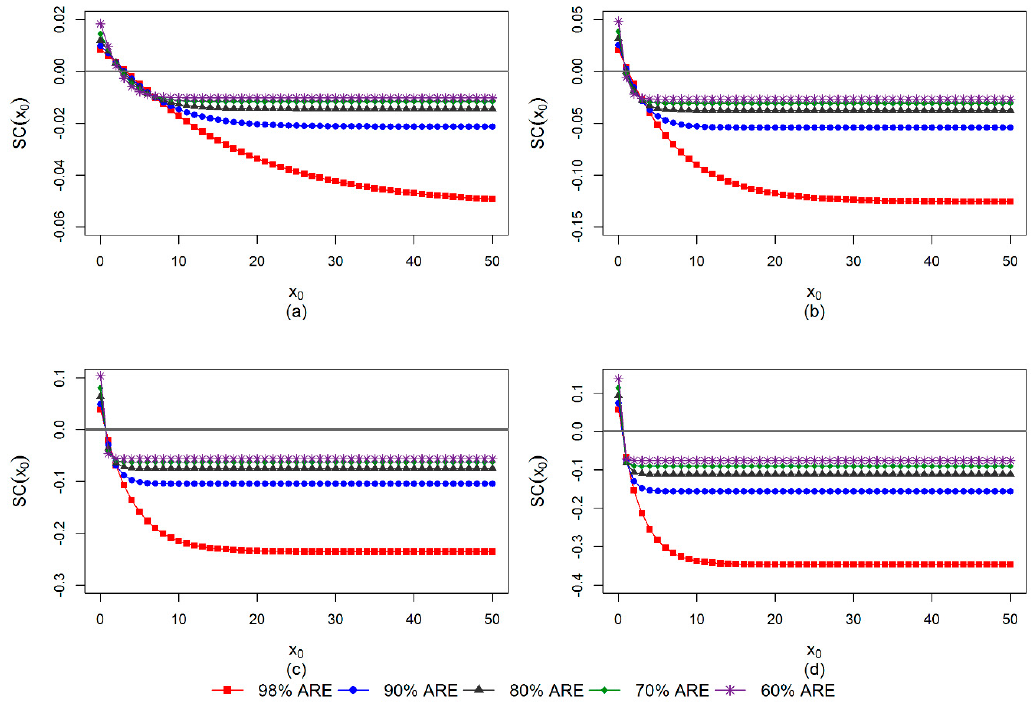
Figure 1. Sensitivity curve (SCs) of PITS estimators for ( a ) θ = 0.5, ( b ) θ = 1, ( c ) θ = 2 and ( d ) θ = 3 with several AREs.